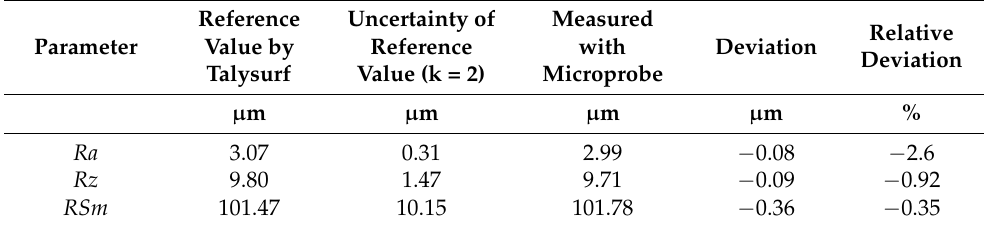
Figure 10. Comparison of the primary profiles of a Mitutoyo 178-601 (S/N 131883) measured with the reference instrument (Talysurf) and with the industrial microprobe setup (at 1.67 mm/s and sampling rate 100 kHz). Table 2. Comparison of average Ra , Rz and RSm parameters measured with Talysurf and an industrial microprobe setup.